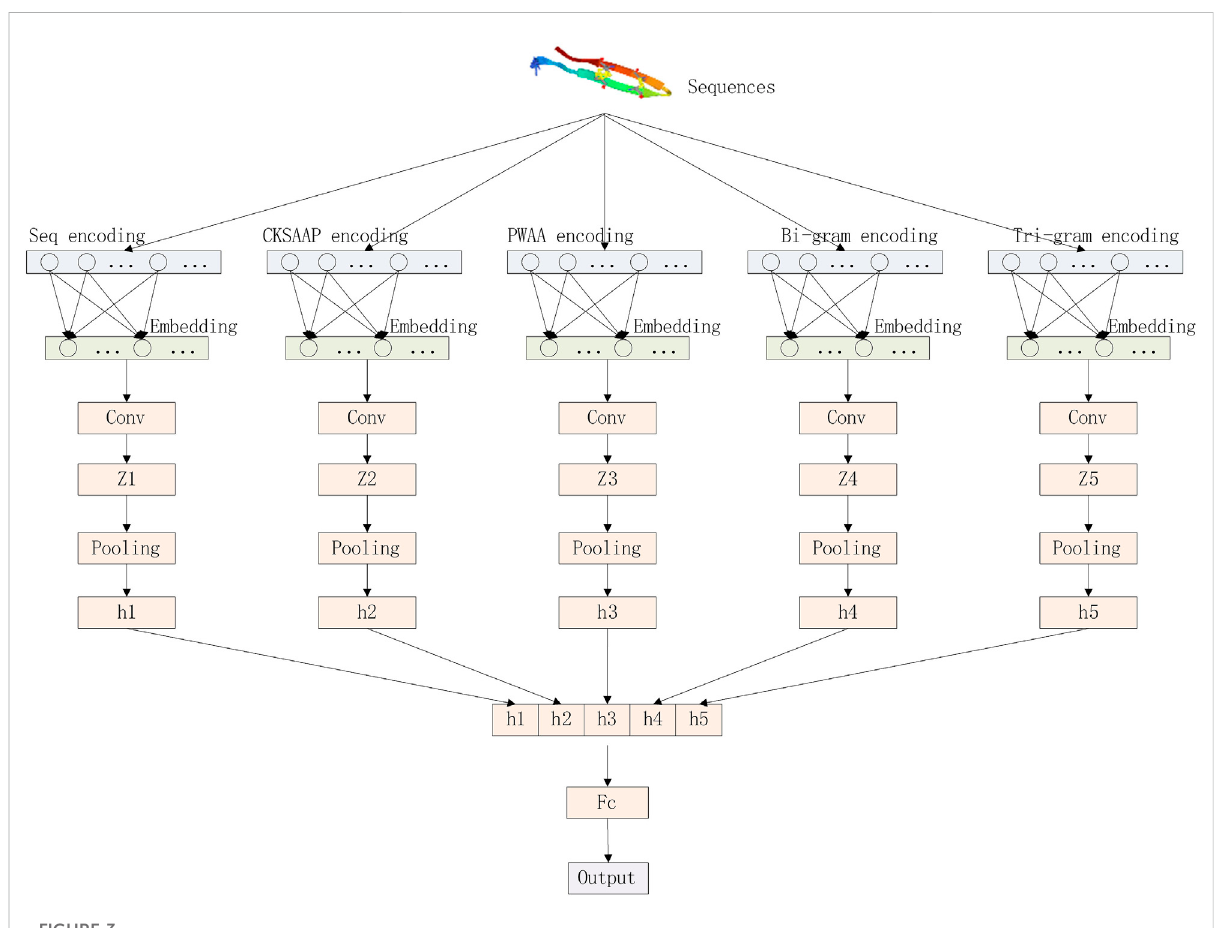
FIGURE 3 Model architecture